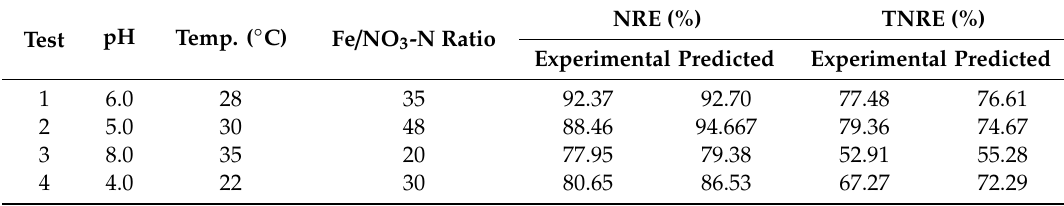
Table 3. Verification experiments at di ff erent